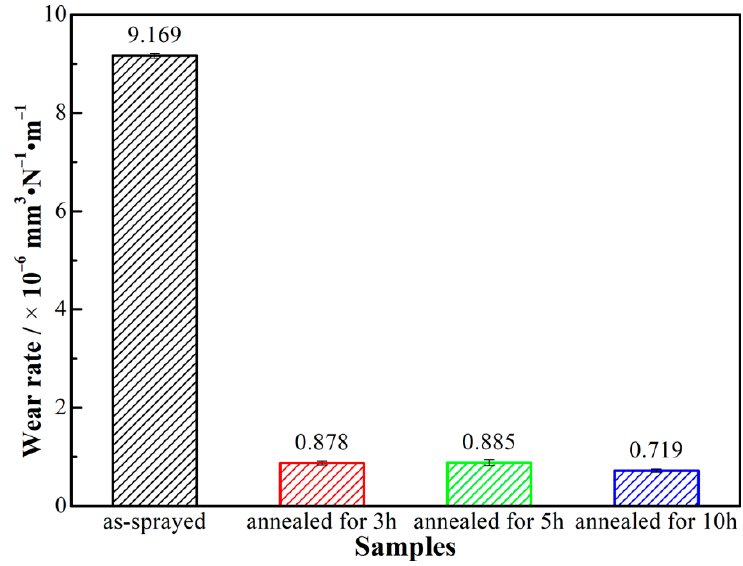
Figure 9. Wear rate of as-sprayed and annealed CoMoCrSi coatings.